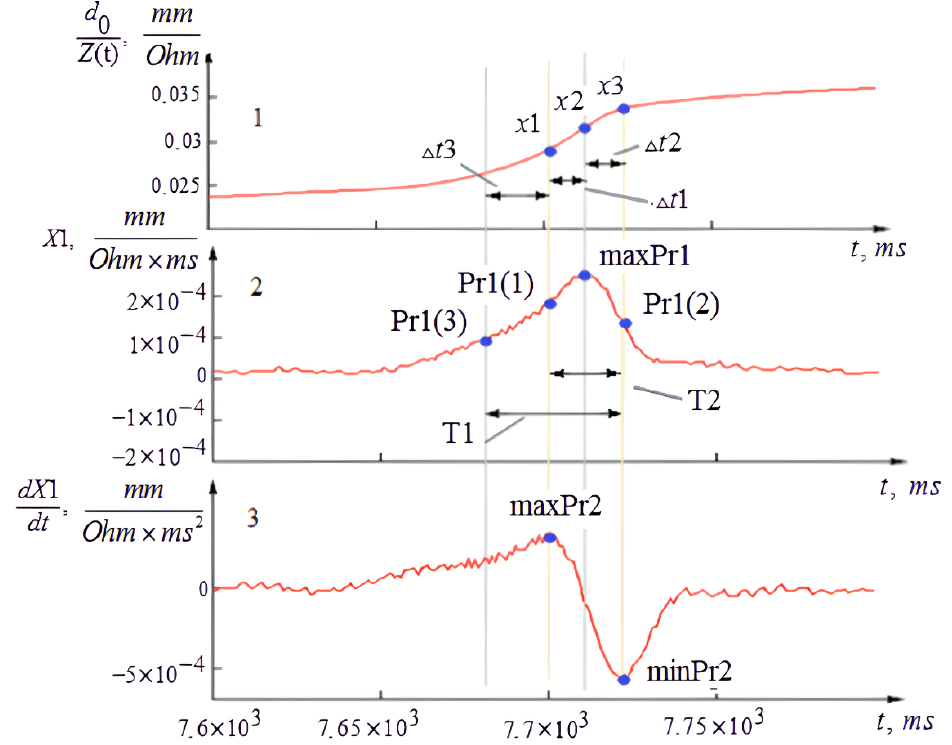
Figure 8. The amplitude-time characteristics of X 1 function. 1—the integral of X 1 function, 2— X 1 function, 3—the first derivative of X 1 function.